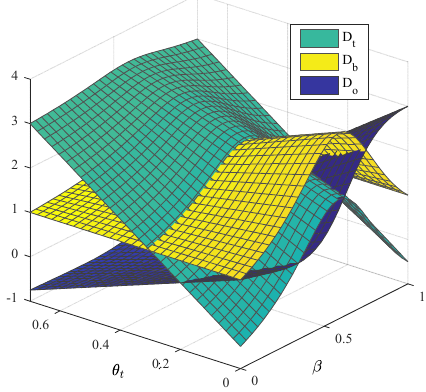
Figure 5. Demand in Scenario U.